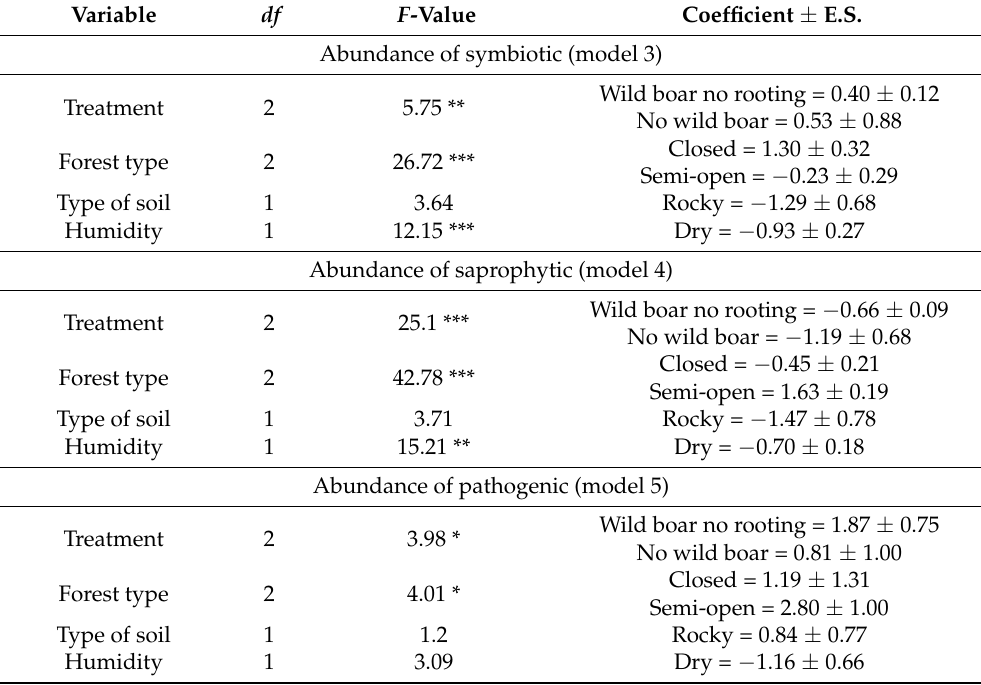
Table 3. Fungal guild abundances (model 3, 4 and 5) as responses to the presence of wild boar and wild boar rooting (three treatments) analyzed with GzLMM. Coefficients for the level of fixed factors were calculated using reference values of the treatment ‘wild boar’ (with rooting) in the variable “treatment”, ‘open’ in the variable “forest type”, ‘soft’ in the variable “type of soil”, and ‘wet’ in the variable “humidity”. (* p < 0.05; ** p < 0.01; *** p < 0.001). df F -Value Coefficient ± E.S.